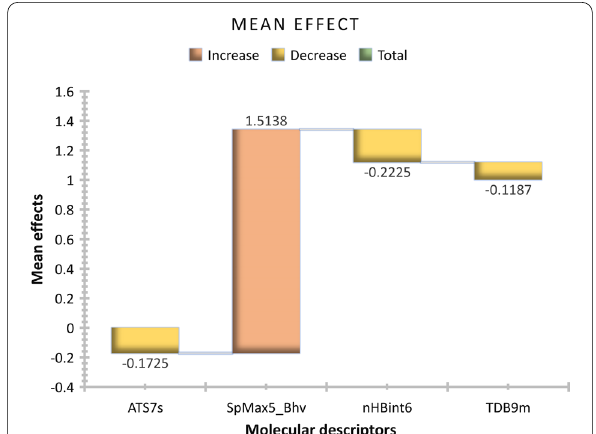
Fig. 3 Mean effect plot of the model descriptors